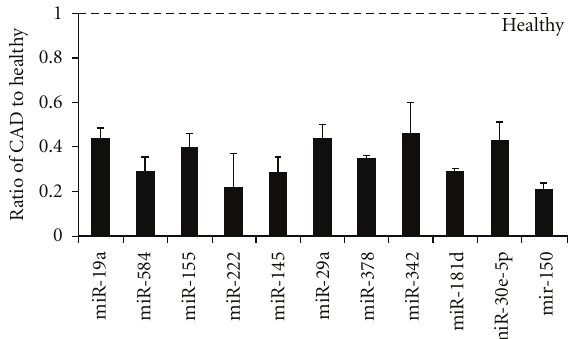
Figure 2: Identification of miRNAs that are decreased in CAD patients compared to healthy subjects. TaqMan miRNA assays were performed on RNA isolated from blood obtained from 2 di ff erent groups: patients with angiographically significant CAD ( n = 15) and healthy volunteers ( n = 5). P values: miR-19a = .012, miR-584 = .036, miR-155 = .002, miR-222 = .001, miR-145 = .008, miR-29a = .012, miR-378 = .001, miR-342 = .001, miR-30e-5p = .02, and miR-150 =